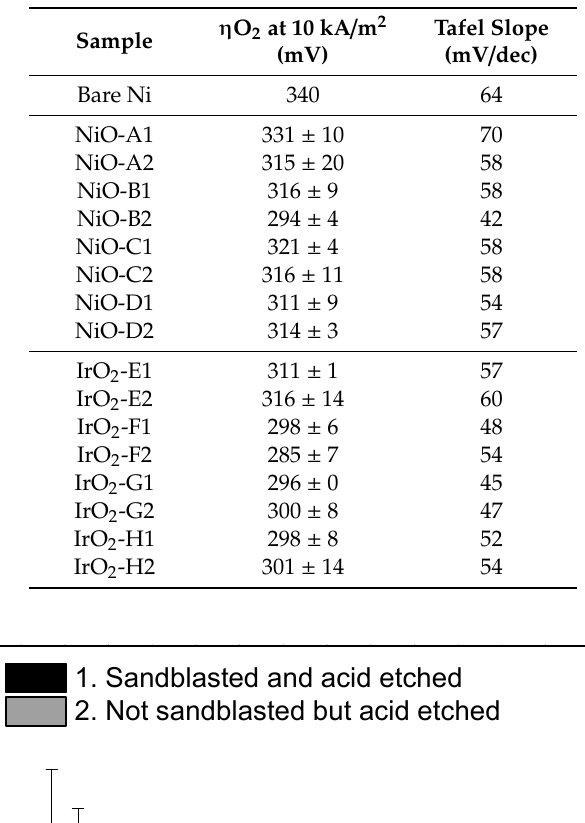
Table 4. Summary of the OER catalytic activity ( η O 2 at 10 kA / m 2 and Tafel slope) of the NiO and IrO 2 thin films.